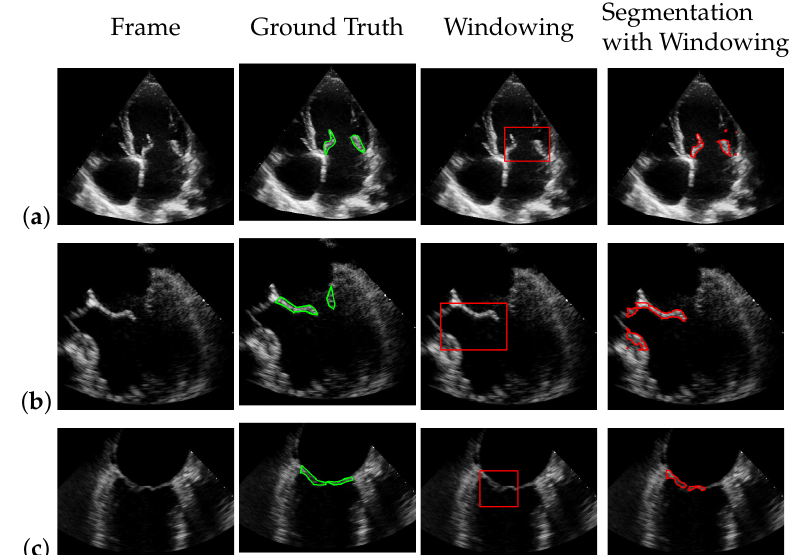
Figure 17. Best ( a ), worst ( b ) and an average ( c ) detection and segmentation result in terms of the recall and f1-score. The green contour indicates the ground truth segmentation, the red contour indicates the detected window location and the calculated segmentation.